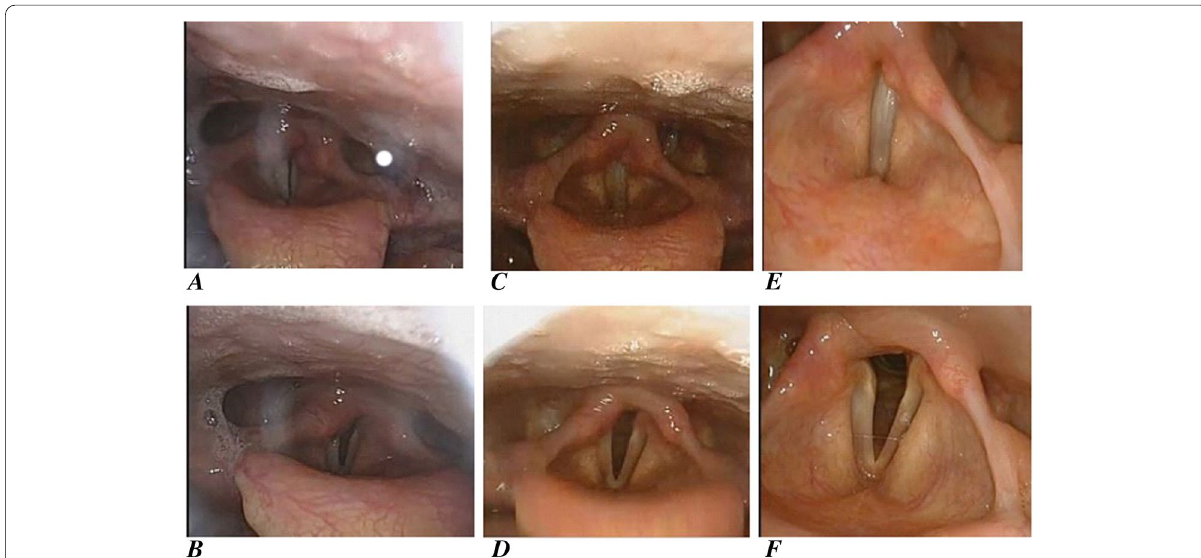
Fig. 3 Case rt vocal-fold paralysis pre- and post-injection. A , B The laryngoscopic examination pre-injection, A during adduction with evident glottal incompetence and B during abduction. C , D are from the 2-month follow-up; the glottis is completely closed with resolved glottal incompetence in C and during abduction in D . E , F From the 1-year follow-up visit, indicating that the injection is still